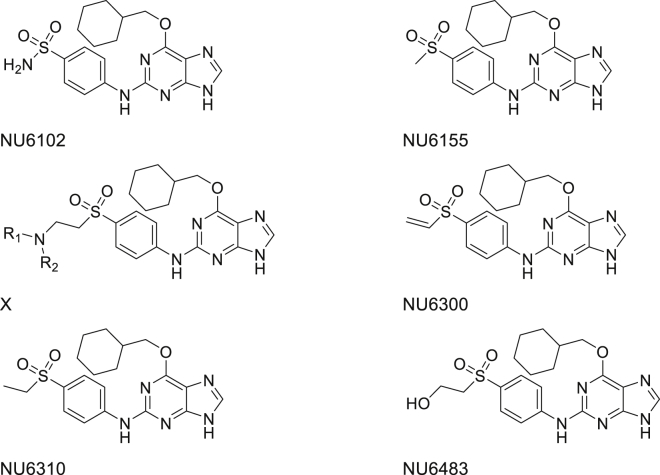
Compound Structures